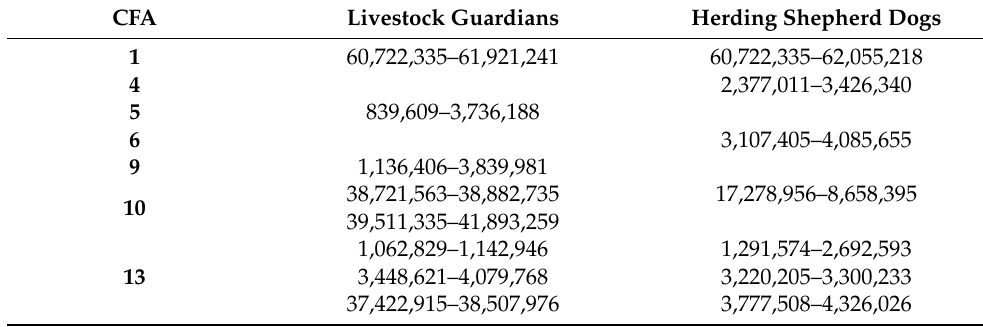
Table 2. Runs of homozygosity islands found in livestock guardian and herding shepherd dogs. CFA Livestock Guardians Herding Shepherd